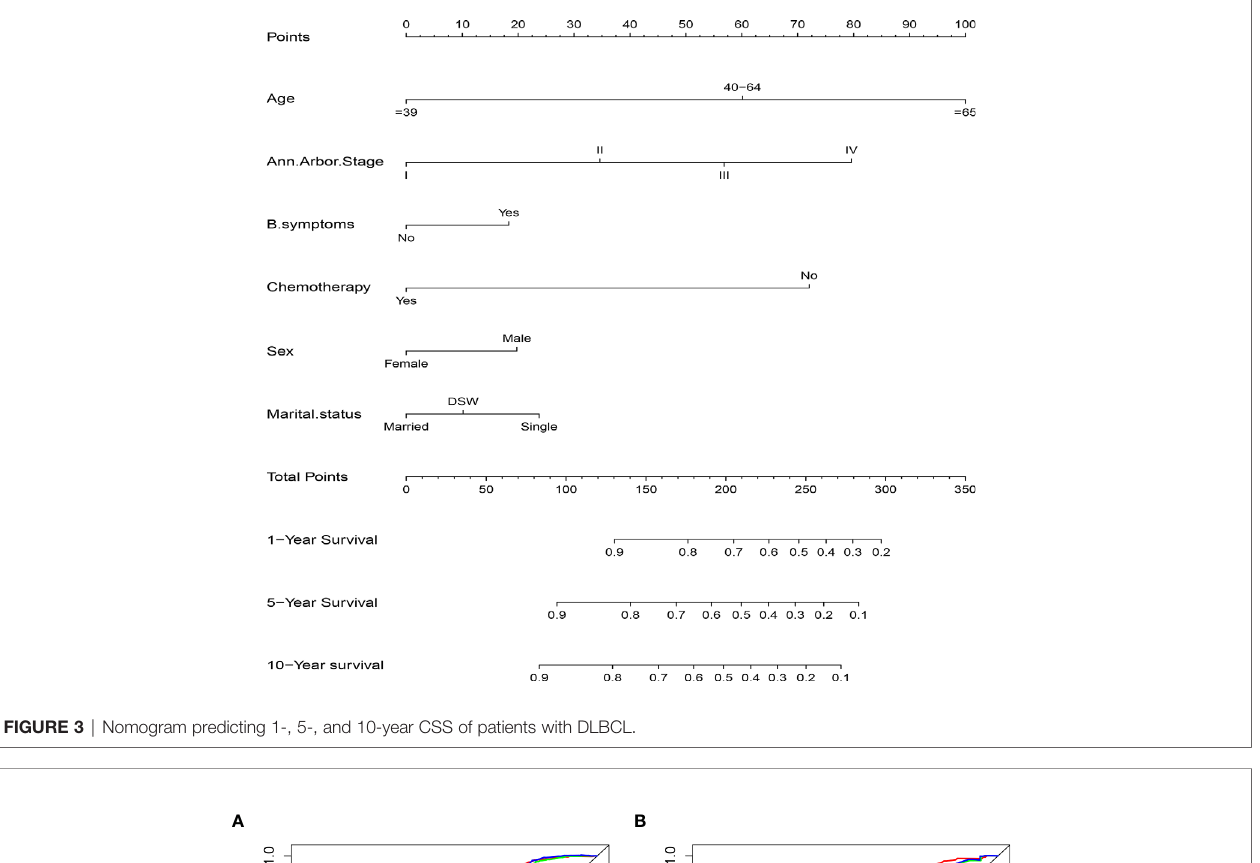
FIGURE 3 | Nomogram predicting 1-, 5-, and 10-year CSS of patients with DLBCL.